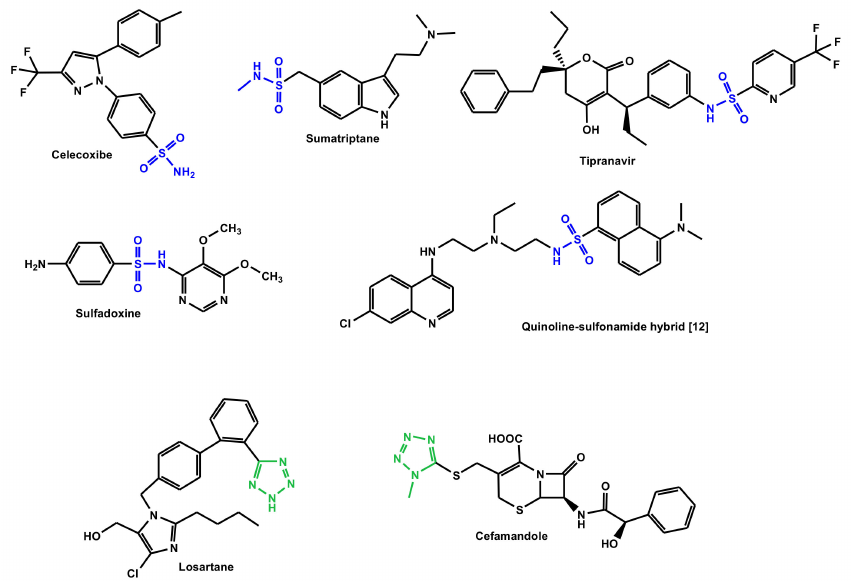
Figure 1. Drugs with sulfonamide or tetrazole partial structure used against inflammation (Celecox- ibe), migraine (Sumatriptane), hypertonia (Losartane), in antiretroviral therapy (Tipranavir) and as antimicrobial agents (Sulfadoxine, Cefamandole, Quinoline–sulfonamide